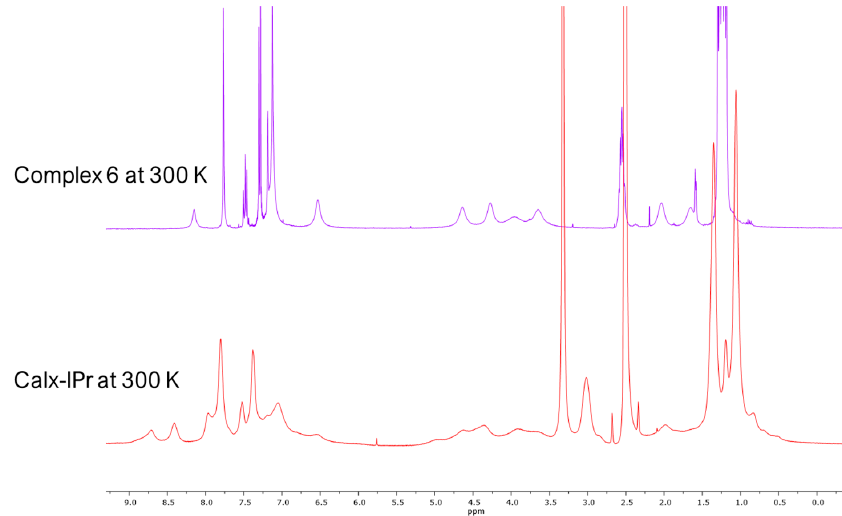
Figure 2. 1 H NMR spectrum of complex 6 at 300 K in CDCl 3 (Top) and Calx-IPr at 300 K in DMSO- d 6 (Bottom).